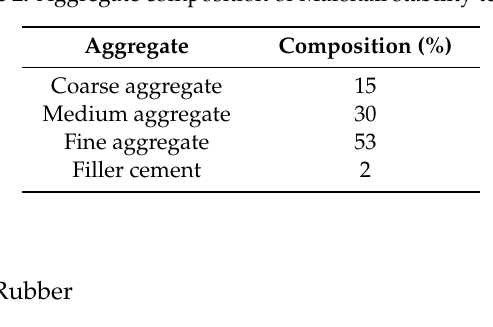
Table 2. Aggregate composition of Marshall stability testing.